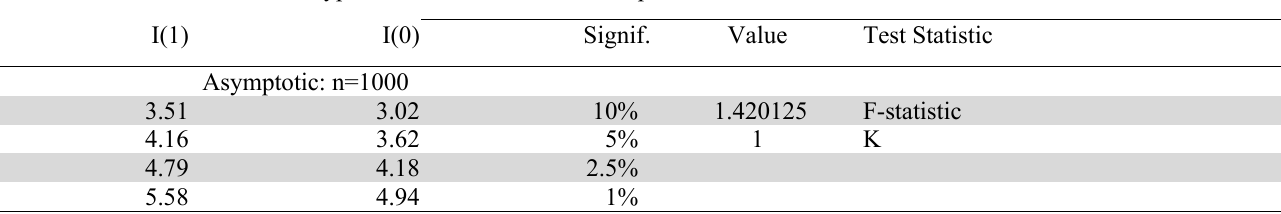
Cointegration Test